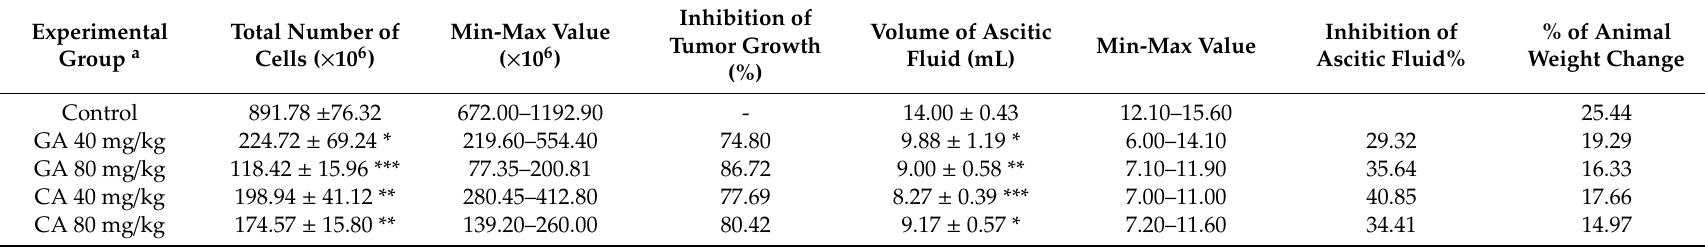
Table 1. E ff ect of GA and CA on the total number of cells, tumor growth inhibition, ascites volume, and animal weight change (%) of mice bearing EAT.